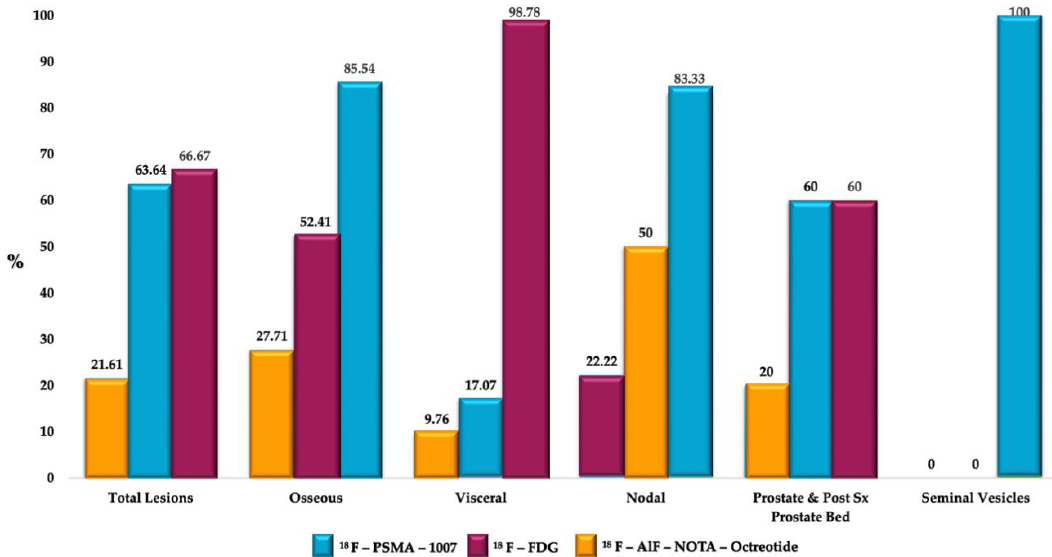
Figure 3. Percentage of lesions detected by 18 F-PSMA-1007, 18 F-FDG and 18 F-AlF-Nota Octreotide by regions.